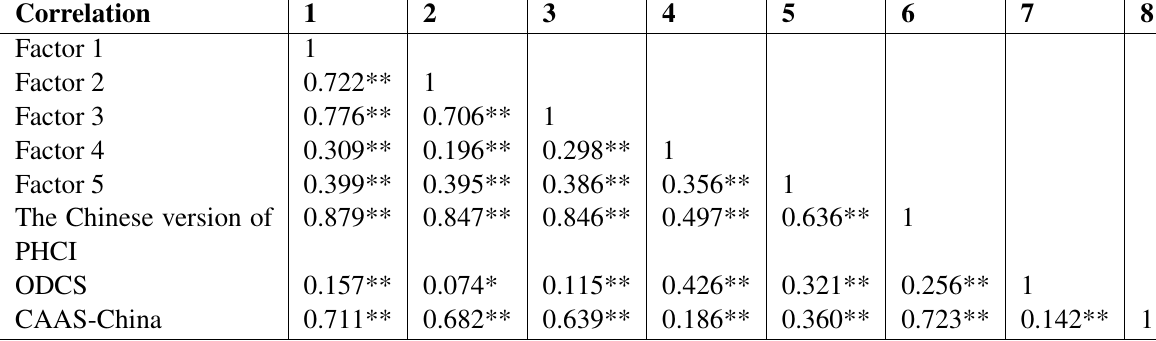
Table 4 Correlation between the Chinese version of PHCI and efficacy targets ( n =